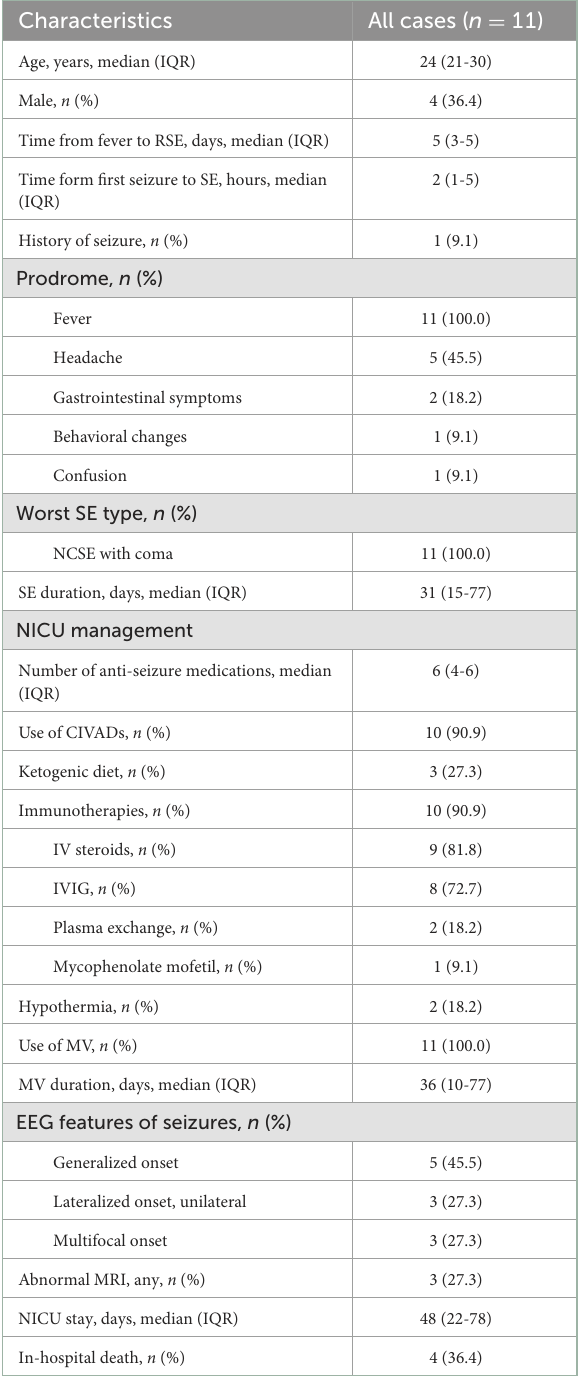
TABLE 1 Clinical characteristics of adult cryptogenic FIRES